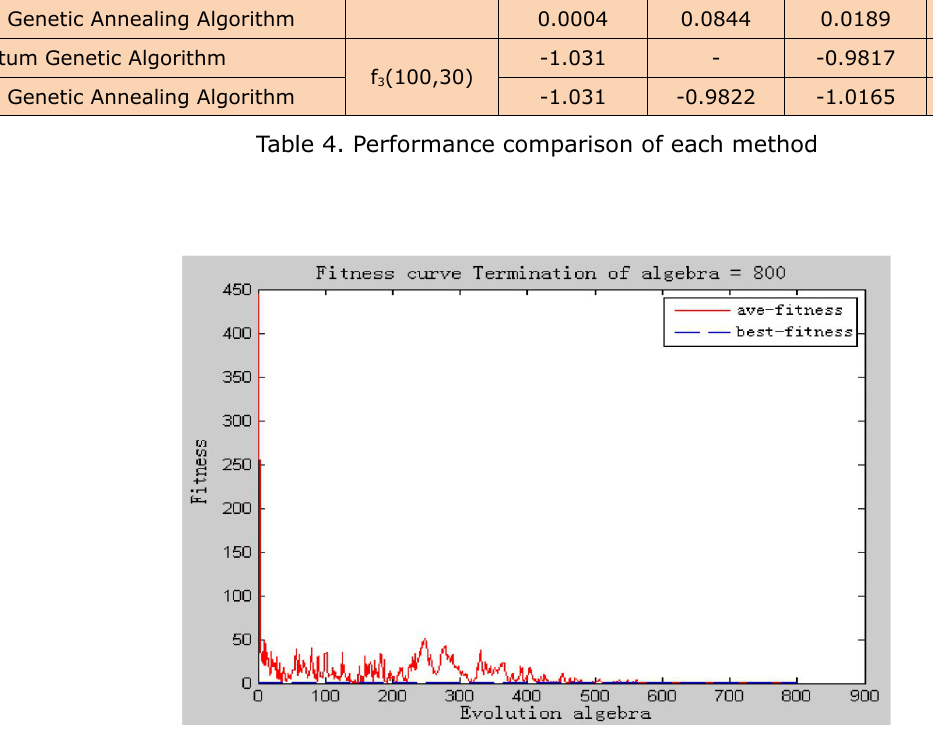
Figure 5. Genetic annealing algorithm of f 2